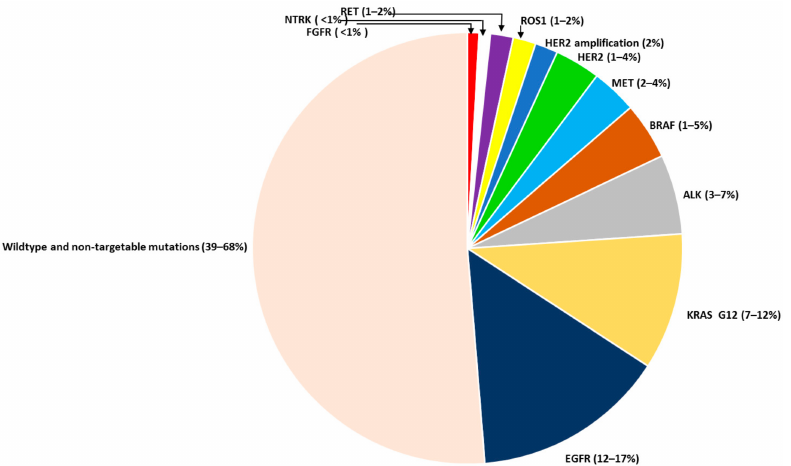
Figure 1. Incidence of NSCLC gene